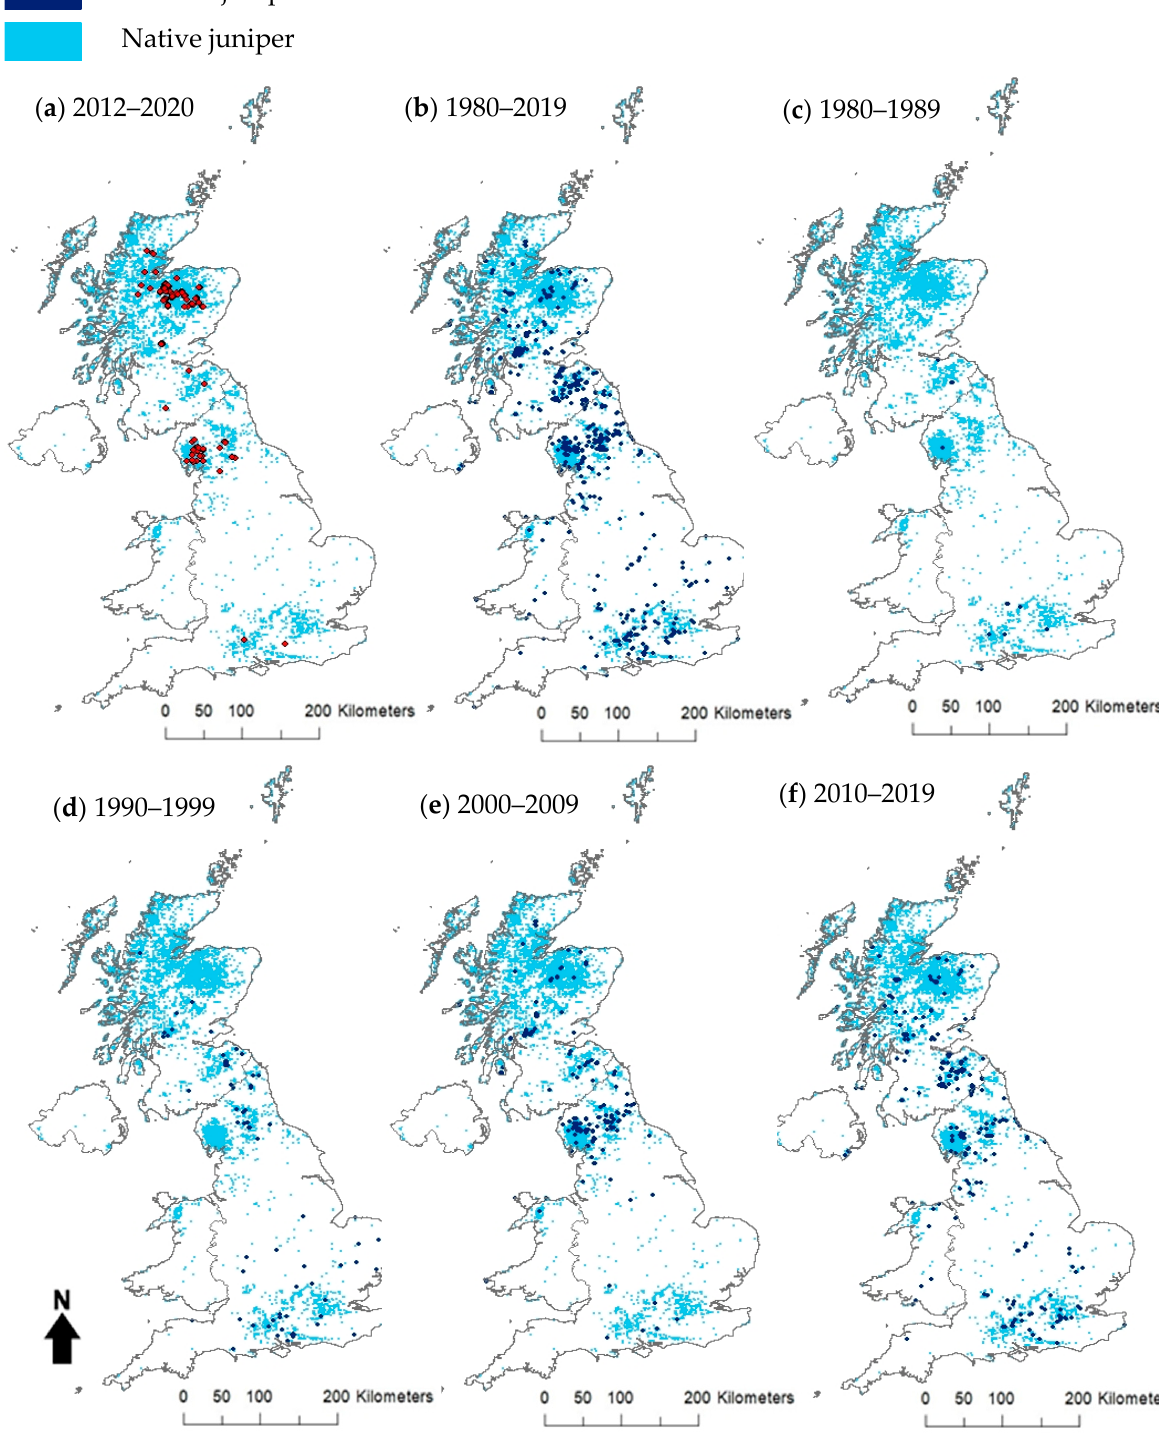
Figure 1. Comparison of the distribution of all P. austrocedri detections located in the wider environment ( a ) with all wider environment juniper planting carried out 1980–2019 ( b ) and carried out per decade ( c – f ). Planting locations (dark blue) are mapped against the distribution of native juniper (light blue) recorded since 1990. Maps a and b can be viewed online at https://floradonald-juniper-planting-2020.shinyapps.io/Planting2/ accessed on 9 June